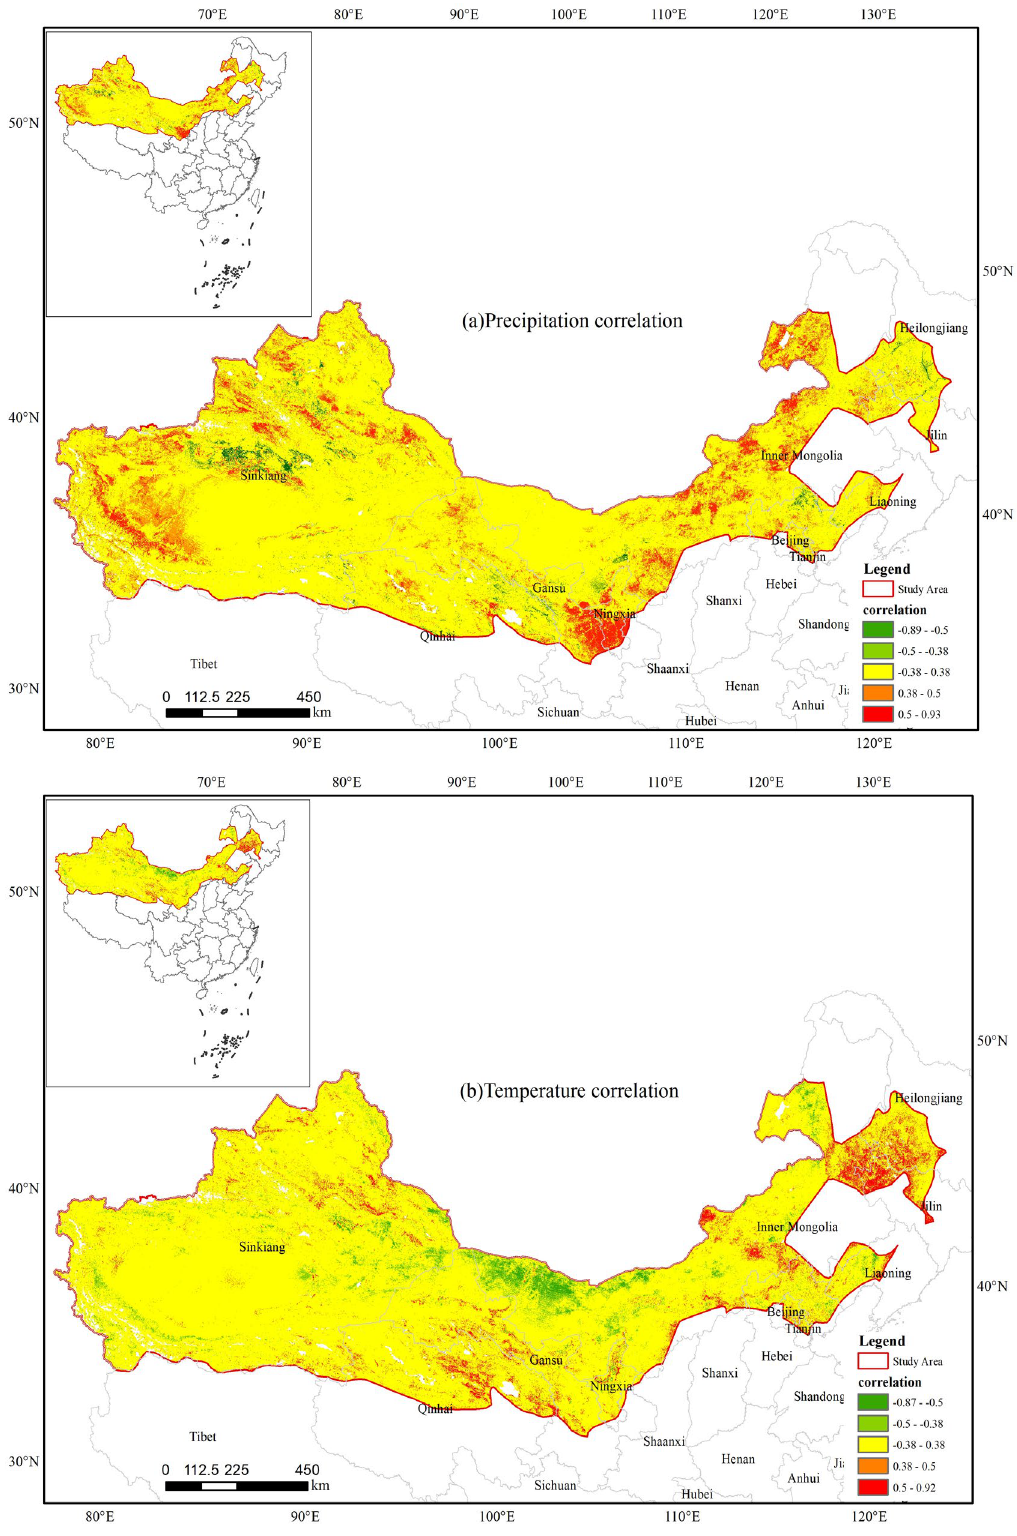
Figure 12. Distribution of correlation coefficients between vegetation cover and temperature and precipitation in the Three North Project areas from 2000 to 2020 (first: precipitation correlation, second: temperature